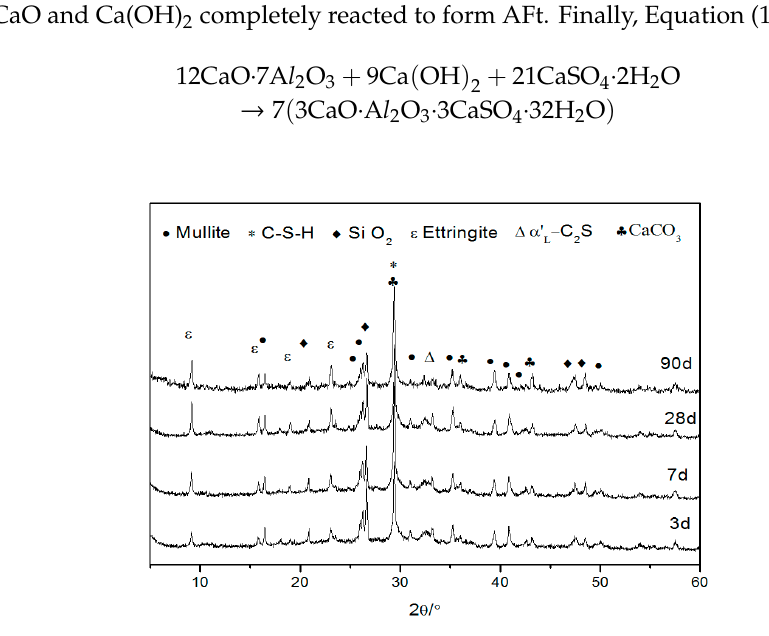
Figure 6. XRD patterns of pastes hydrated for different ages.